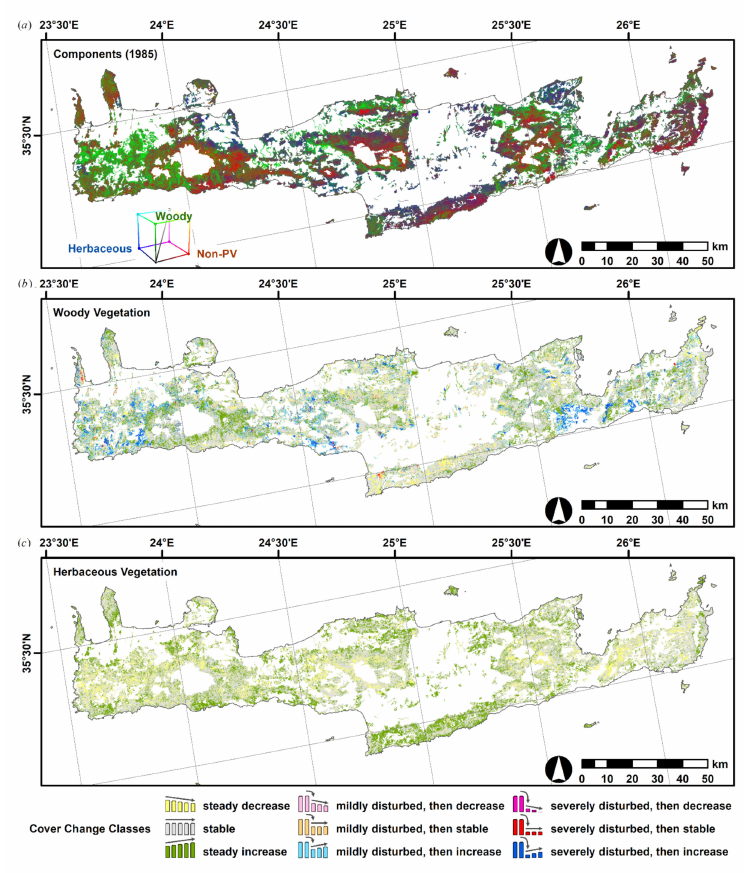
Figure 8. Long-term change of vegetation components over the study period 1984–2006. ( a ) RGB representation of the major vegetation components for 1985; stretched from 0–100%; an animation for the complete time series is available in the supplemental material. ( b , c ) Syndrome-based labeling of land-use change classes for woody and herbaceous vegetation trajectories, respectively. White areas are non-natural areas or above 1500 m a.s.l., which were out of scope of this study. Entirely different drivers may relate to changes predominantly occurring in the herba- ceous or woody cover, or a combination thereof (Figure 9). Thirty-eight percent of the areas with steadily decreasing woody cover (yellow left) do not show substantial changes in the herbaceous cover (gray right); 56% show signs of increasing herbaceous cover (green right). Thus, when only analyzing total vegetation cover as measured via the peak of season metric (Figure 5b), only the first case (yellow left, gray right) was observable. In the second case (yellow left, green right), the long-term decrease in woody cover was compensated by